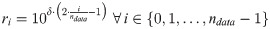
Response rate homogeneity of a linear pathway affect how well models can reproduce their dynamics.Models were fitted towards data that was generated with different levels of response rate inhomogeneity. The synthetic data was generated using linear pathway models (Eqs 2 and 3) with parameters γ = 1 and ri=10δ·(2·indata-1)∀i∈{0,1,…,ndata-1} where δ is a parameter that governs the inhomogeneity of the rate parameters. For δ = 3, the rate parameters were thus logarithmically spread from 0.001 to 1000. (A) The cost values (lower is better) of models fitted to an 11-step linear pathway, plotted against the inhomogeneity parameter, δ, used to generate the synthetic data. (B-E) Samples of the model/data fit for the optimised parameter sets, as marked in (A). The fixed-rate model (Eqs 8 and 9) is compared with the two-step model (Eqs 2 and 3) since they have the same number of free parameters. (F) The optimised value for the fixed-rate model parameter n compared with the inhomogeneity of the response rates (ndata = 11). (G) and (H) The cost values for the two-step model and the fixed-rate model, respectively, when fitted to pathways of different lengths and degrees of inhomogeneity. (I) The ratio of the cost values for the fixed-rate and the two-step models. Blue indicates that the fixed-rate model did better while red indicates that the two-step model did better. White indicates that the two models performed equally well.